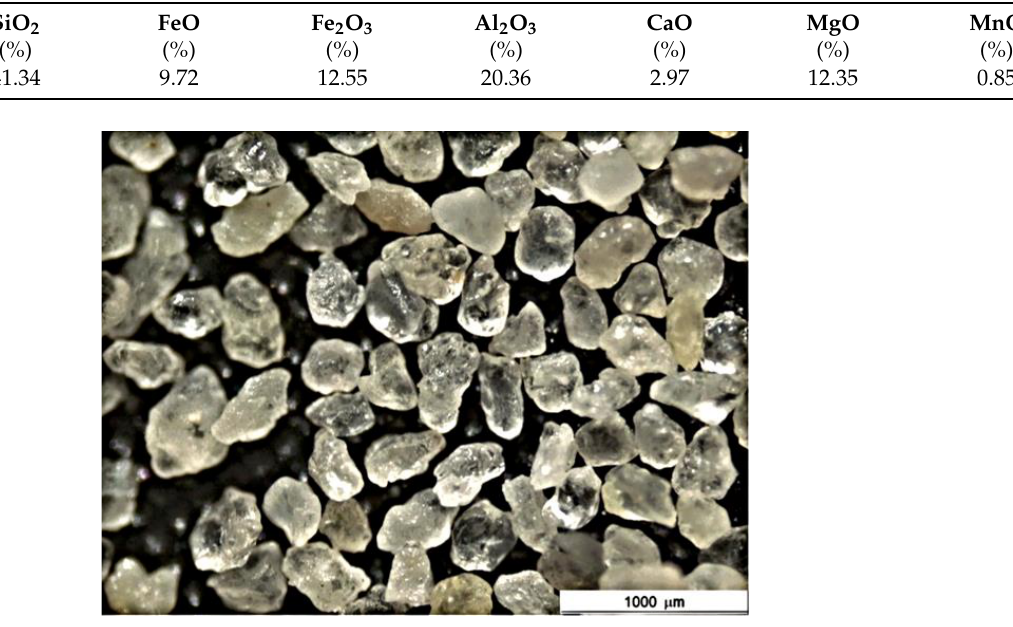
Figure 3. Garnet